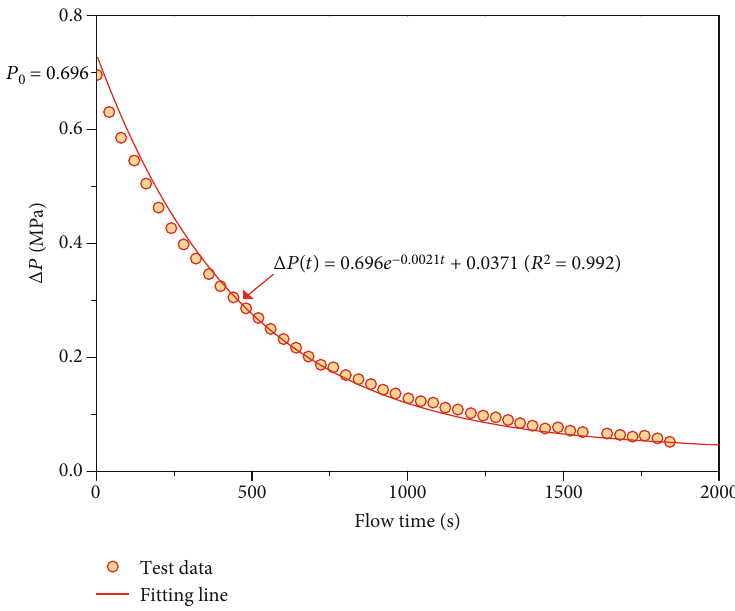
Figure 4: A representative di ff erential pressure versus fl ow time